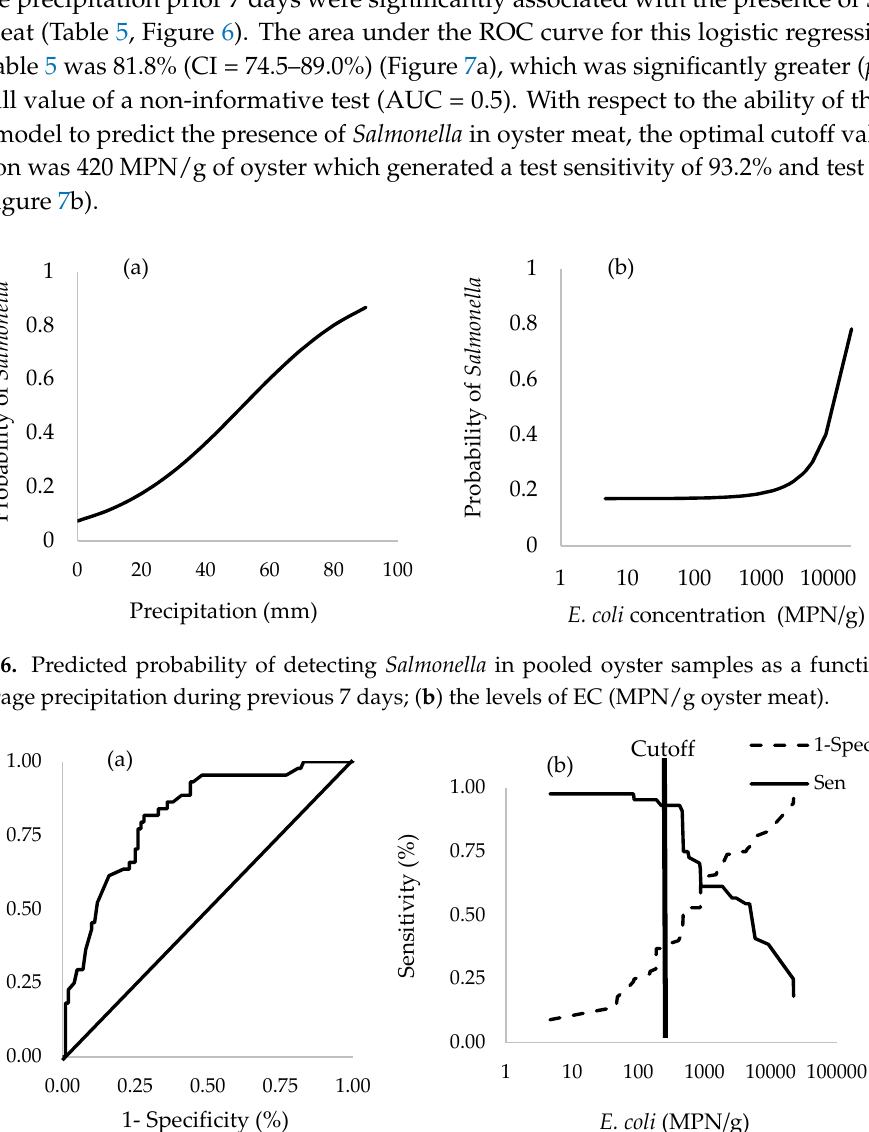
Figure 5. Predicted average concentration of EC (MPN/100 mL of estuarine water) as a function of: ( a ) average precipitation over 7 days; ( b ) ambient air temperature